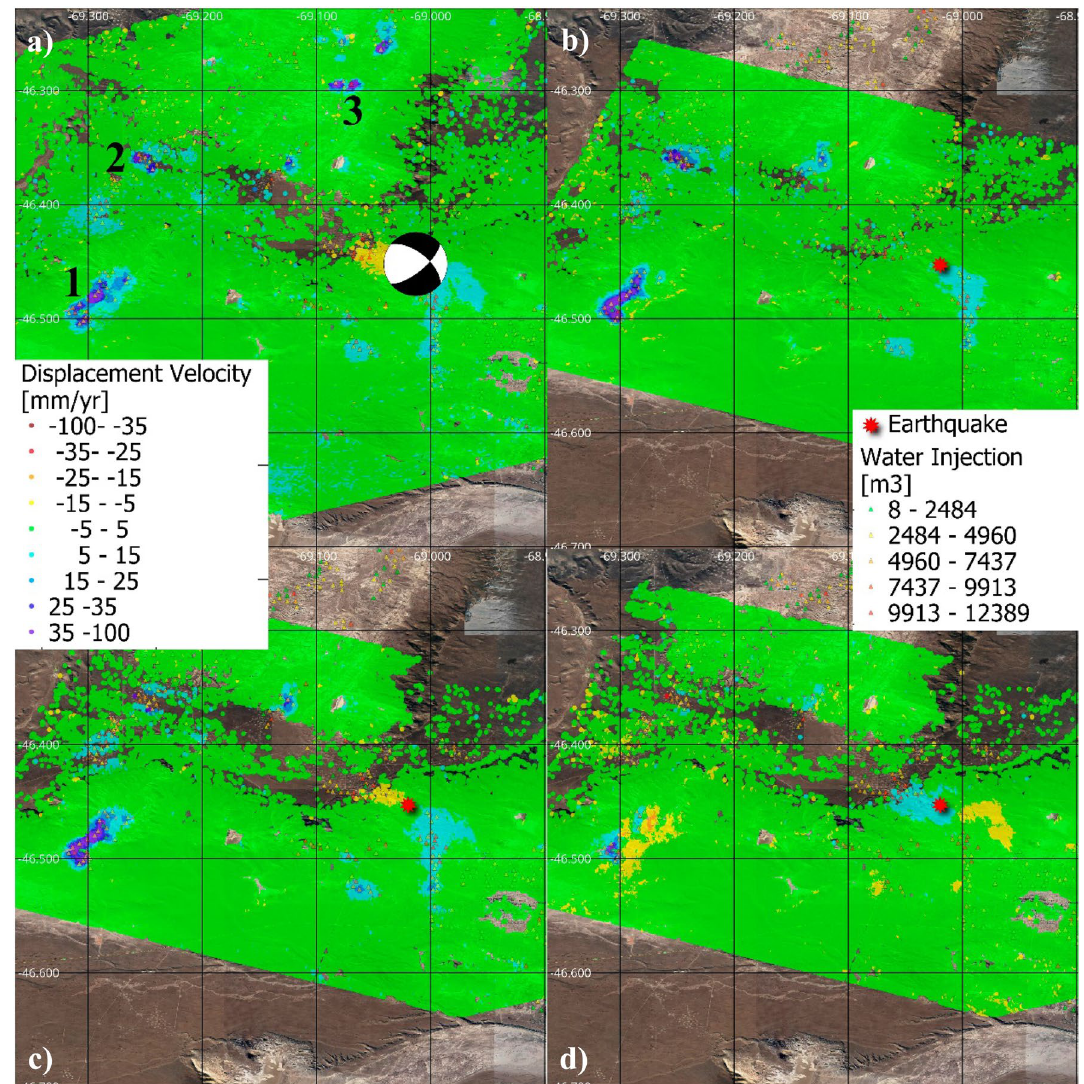
Figure 6. Ground displacement velocity maps obtained exploiting the SBAS technique observed from ascending trajectory ( a ) and descending trajectory ( b ) in the GSJ basin superimposed to a Google satellite image ( c ) and ( d ) show the ground displacement vertical and West–East component respectively. The analysed period spans from January 2017 to December 2020. Positive LOS values are movements towards the satellite. (1, 2, 3) point the areas with higher rates. The red star indicates the location of the ML 5 2019 October 17 earthquake epicentre. ( a ) Shows The Global Centroid Moment Tensor (GCMT) focal mechanism of this estimated precision is ± 2.9 mm/year and ± 2.6 mm/year for the descending and ascending datasets, respectively. Time series precision is estimated as 4.3 and 2.1 mm for the ascending and descending respectively. For this study, areas of ground displacement identified in Fig. 6 as zones 1, 2 and 3 and the coseismic defor- mation marked with a star are analysed in detail. Hydrocarbon production and ground displacements in the GSJ basin. The displacement rates measured using the ascending and descending trajectories show good agreement in the analysed moving areas (Fig. 6). We can notice some differences that can be explained through its decomposition in horizontal and vertical components. A clear example is observed in zone 1, where the east flank and in particular north-east corner shows a clear blue sector in the ascending result which is less visible in the descending dataset. In this particular case, the differ- ence can be explained by a horizontal component of the movement explained by the local topography of the area which is south-west oriented. There is also a residual error due to phase jump in the ascending dataset triggered by a long period without acquisitions. The average displacement time series estimated for zones 1, 2 and 3 using the ascending, descending and vertical trajectories (orange, blue and gray dots, respectively) are shown in Fig. 7b–d. They display similar mag- nitudes for the ascending and descending trajectories in the areas with maximum movement. Thus, according